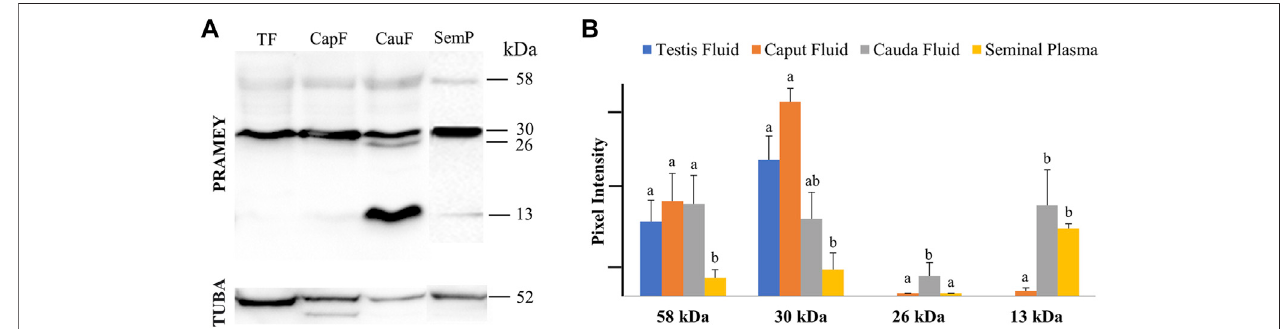
FIGURE 2 | Expression of PRAMEY isoforms in bovine testis (TF), caput epididymal fl uid (CapF), cauda epididymal fl uid (CauF), and seminal plasma (SemP). (A) Immunoblotoftotal fl uidproteinineachgroupprobedbyPRAMEYantibodyandthenreprobedby α -tubulin(TUBA)antibody. (B) Quanti fi cationofpixelintensitiesforthe 58, 30, 26, and 13 kDa PRAMEY bands, normalized to the corresponding TUBA. Data are expressed as the mean of the protein pixel intensity ±SEM for testis ( n = 5), epididymal fl uids ( n = 5), and seminalplasma ( n = 9). Signi fi cance wasevaluated between the four types of fl uid (testis, caput, cauda, and seminal plasma) for each PRAMEY isoform (58, 30, 26, and 13 kDa). Values without a common superscript differed ( p < 0.05).